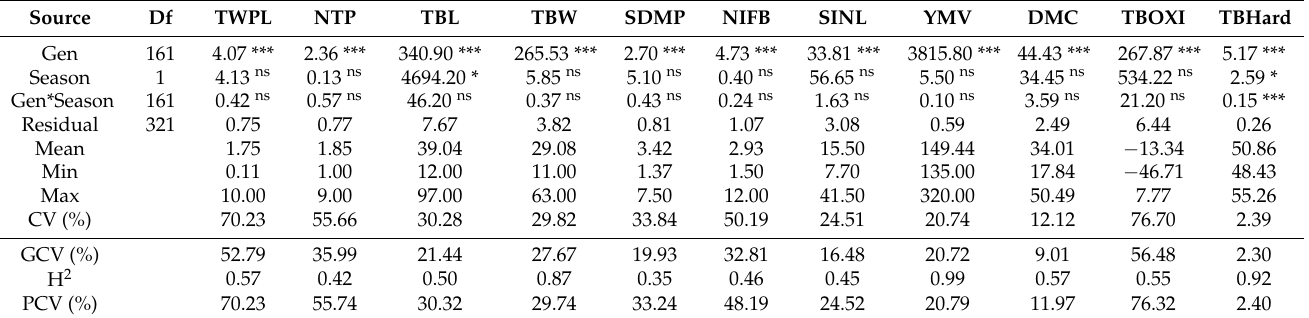
Table 1. Mean squares, mean performance, and variance components and broad-sense heritability of quantitative traits of D. praehensilis accessions across two